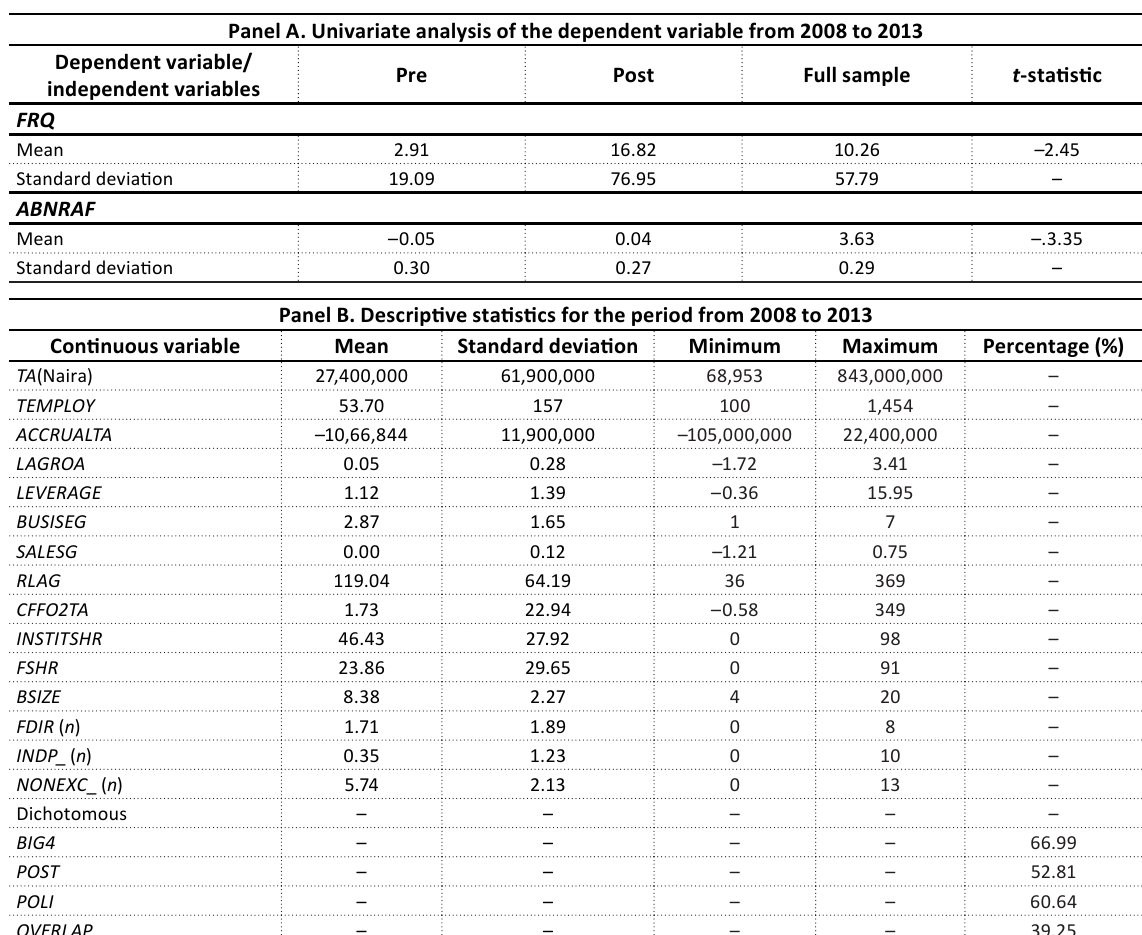
Table 4. Descriptive statistics of the regression variables for the financial reporting quality model Panel A. Univariate analysis of the dependent variable from 2008 to 2013